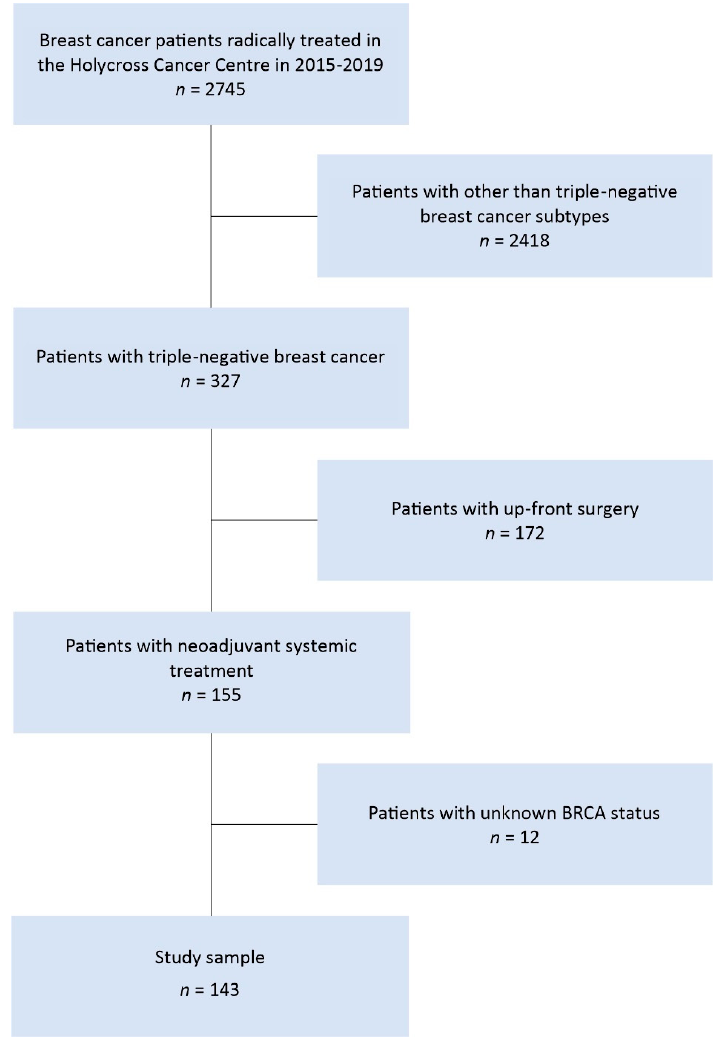
Figure 1. Flow diagram of data selection process.